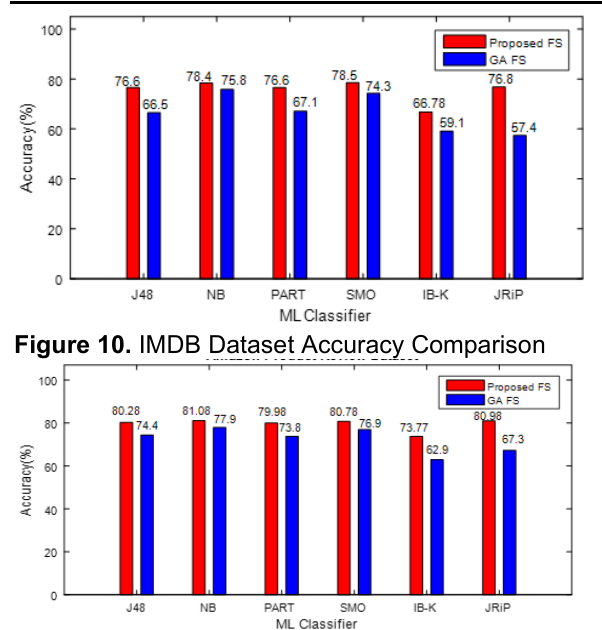
Figure 11. Amazon Dataset Accuracy Comparison